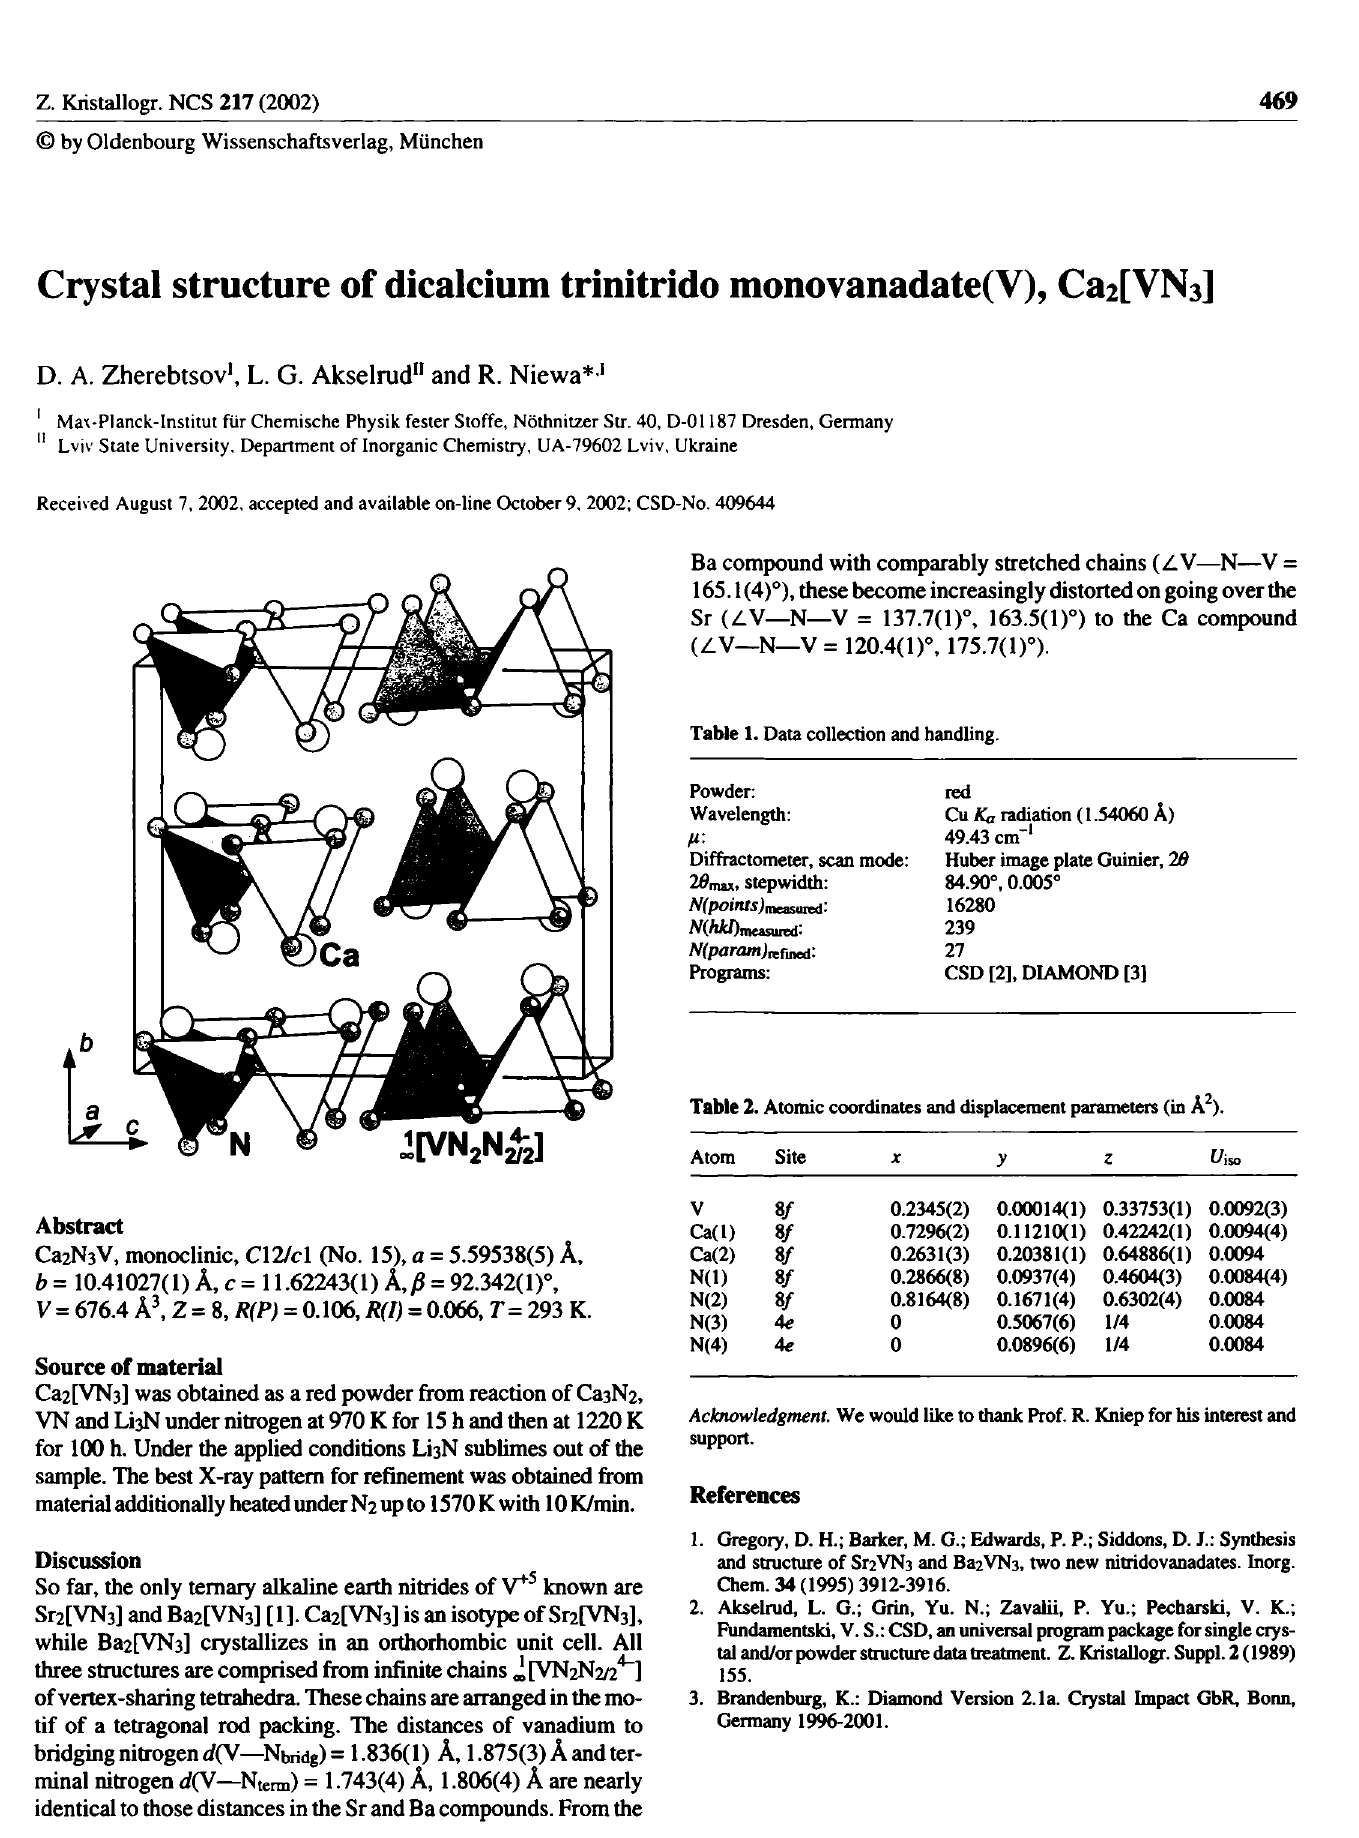
Table 2. Atomic coordinates and displacement parameters (in Â 2